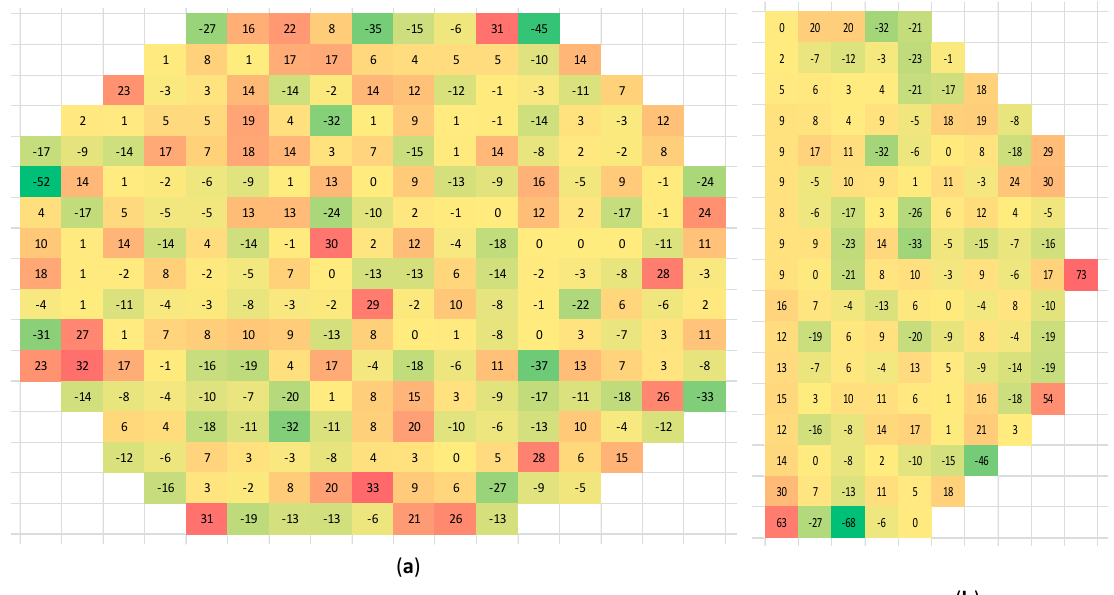
Figure 3. ( a ) Percentage difference in the number of rays absorbed by each pixel when the instrument is regarding the same blackbody calibration source based on two different random number sequences, and ( b ) percentage difference in the number of rays absorbed by each pixel between the calibration case of Figure 2a and the test case of Figure